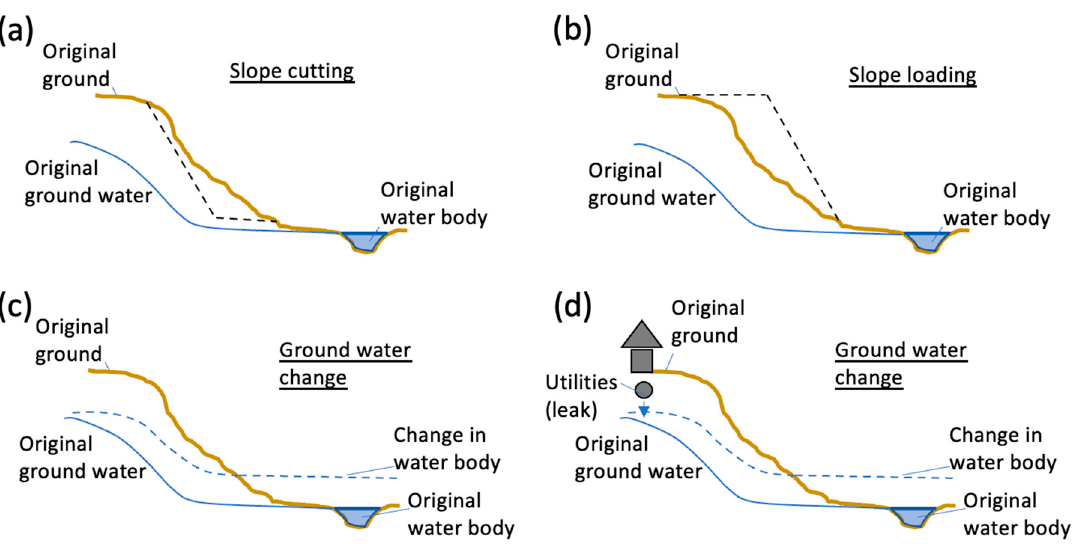
Figure 7. Schematic of examples of possible anthropogenic impact on the stability of valley slopes. Slope cutting ( a ) and loading ( b ) to accommodate infrastructure; change in water bodies ( c ) due to reservoirs or river flow control measures; changes in ground water due to utility leaks from infrastructure near crest of slopes ( d ).